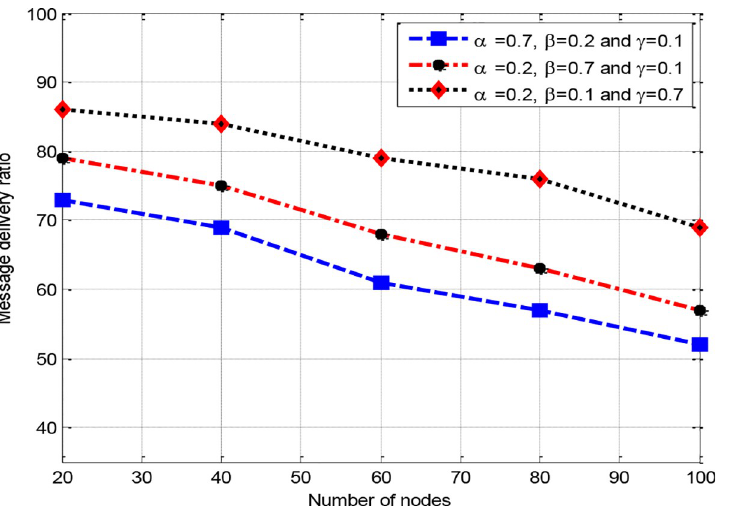
Fig 7. The impact of a number of nodes on network throughput.